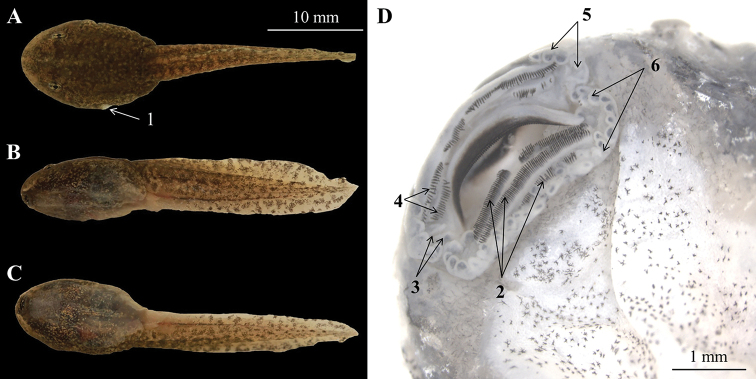
The tadpole CIBTZ20190608019 of Nidirana
yeae sp. nov. in life. A Dorsal view B lateral view C ventral view D mouth structure. Key: 1, spiracle; 2, lower keratodonts; 3, additional tubercles at the angles of mouth; 4, upper keratodonts; 5, labial papillae on upper lips; 6, labial papillae on lower lips.